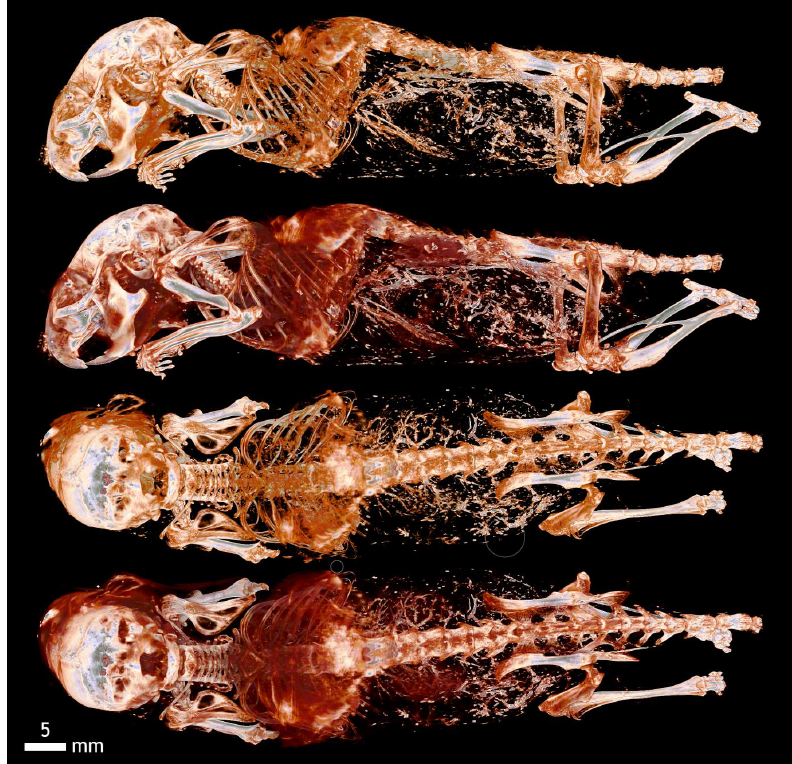
Figure A6. Detail view of the vascular system of the lungs in the chest of the mouse with Aurovist contrast in the sagittal and ventrodorsal scans and detail of the bronchial tree of the lung parenchyma in the same position. It is possible to compare pathologies in the vascular bed and bronchial branching separately.